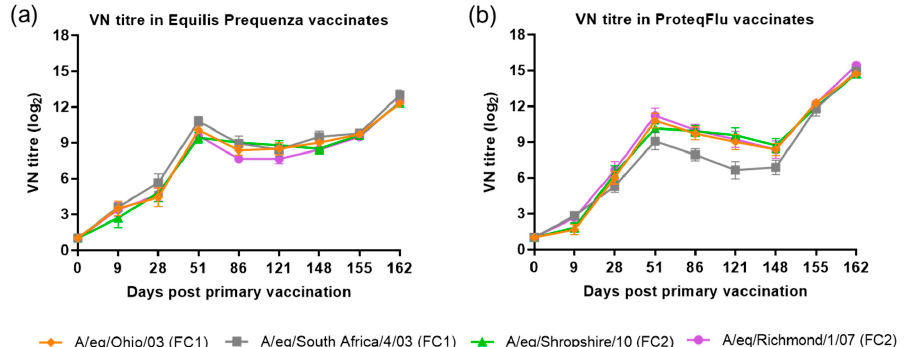
Figure 4. Mean virus neutralisation (VN) antibody titre response in ( a ) Equilis Prequenza-vaccinated horses and ( b ) ProteqFlu-vaccinated horses against H3N8 EIV A/equine/Ohio/03 (FC1) (red diamond), A/equine/South Africa/4/03 (FC1) (blue square), A/equine/Shropshire/10 (FC2) (green triangle) and A/equine/Richmond/1/07 (FC2) (purple dot). Day 0, V1; Day 28, V2; Day 148, challenge. Error bars represent SEM. A titre of <2 was converted to 1 for graphical presentation.